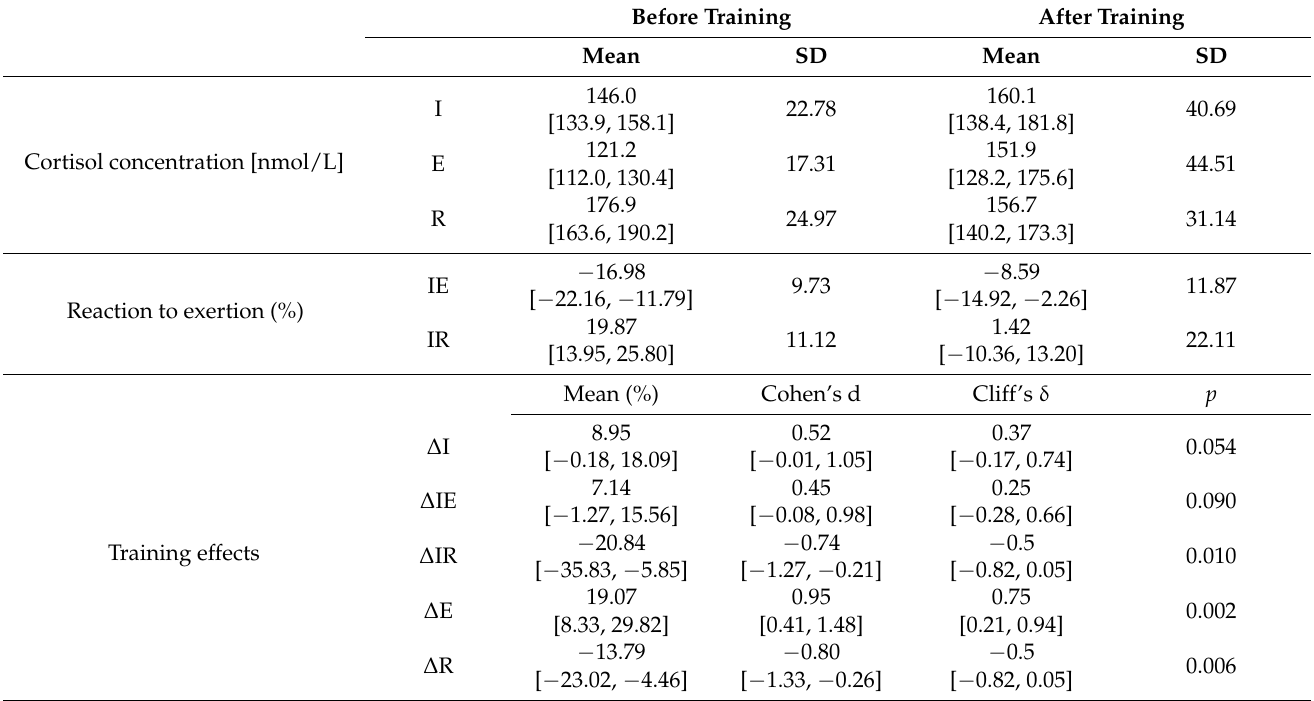
Table 2. Results of the experiment.